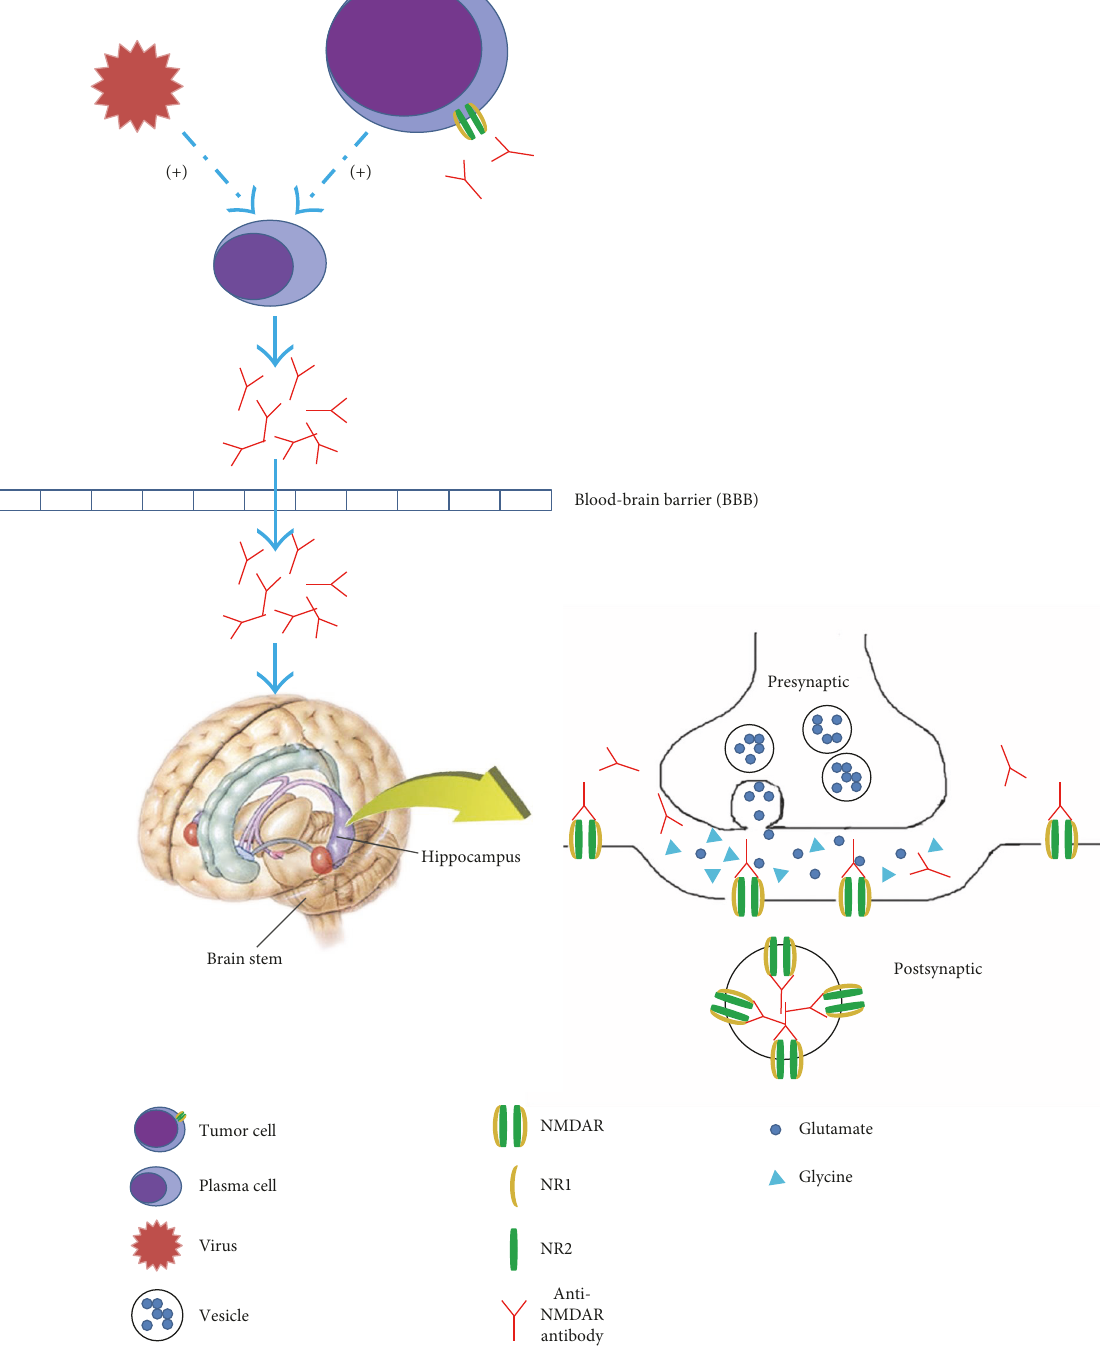
Figure 1: Possible pathogenesis of anti-NMDAR encephalitis. Anti-NMDAR antibodies synthesized by peripheral plasma cells pass through the broken blood-brain barrier (BBB). Tumors, which express NMDA receptors, as well as viral infections, may play a role in triggering the synthesis of anti-NMDAR antibodies. IL-6 and IL-17A might play an important role in the intrathecal antibody synthesis. NMDA receptors are expressed in many regions of the brain, including the hippocampus, brain stem, and neocortex. Anti-NMDAR antibodies bind selectively to synaptic and extrasynaptic NMDA receptors. The speci fi c bind leads to crosslinking and internalization of those receptors. The number of NMDA receptors on the postsynaptic membrane decreases. The e ff ect is titer-dependent and reversible after antibody titers decrease. Thus, anti-NMDAR antibodies lead to a speci fi c, titer-dependent, and reversible reduction of NMDA receptors on postsynaptic dendrites which results in neuronal